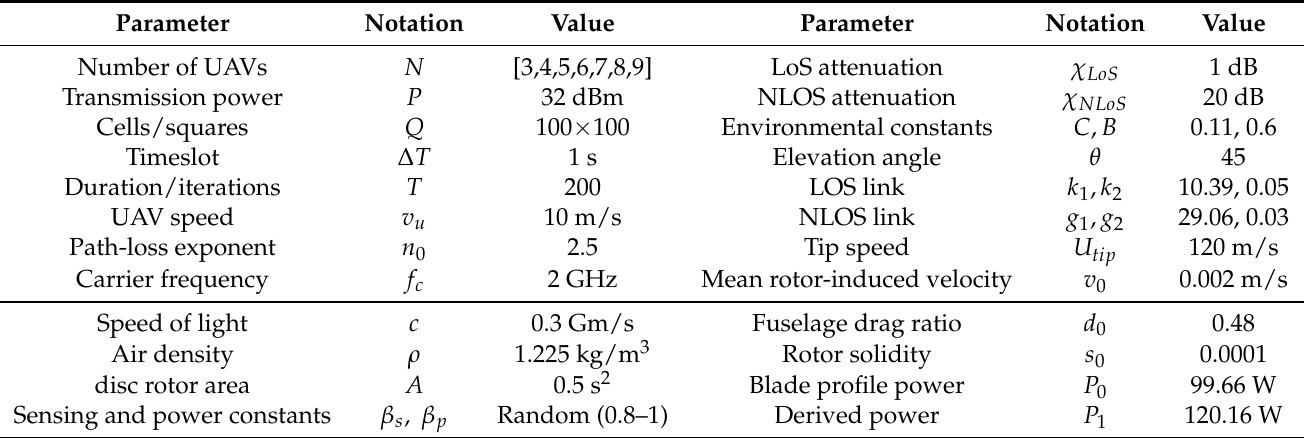
Table 3. Simulation setting for the UAV